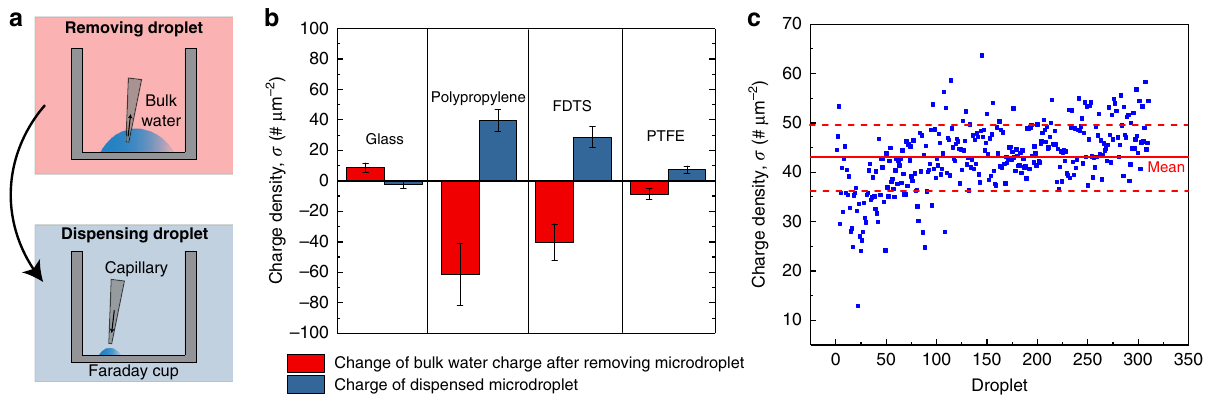
Fig. 4 Quanti fi cation of the excess electrical charges carried by water droplets during pipetting. a Removing droplet: we placed 1 mL of water (reservoir) inside a Faraday cup connected to an electrometer and extracted 15 – 50 μ L aliquots at a time. Dispensing droplet: next, we dispensed the exctracted droplets into an electrometer to quantify their excess charges. We found that the charges incurred by the water reservoir and the withdrawn aliquots were equal and opposite. b Charge balance: charging of the water reservoir and the withdrawn aliquot using capillaries made of borosilicate glass, polypropylene, FDTS-coated glass, and PTFE. The charges on the water reservoir after withdrawing water aliquots using different capillaries are presented in red; commensurate (opposite) charges on the aliquots are presented in blue. (Note: the y -axis presents charge density, obtained by normalizing the charges by the liquid-solid interfacial area). Error bars represent the standard deviation of ten measurements. c Charge density of over 300 water droplets (50 μ L each) loaded and dispensed from the same polypropylene capillary into an electrometer. The red dotted lines represent the ± 1 standard deviations about the mean value of the surface charge density of polypropylene: σ ¼ (cid:2) 0 : 7 ± 0 : 1 nC cm − 2 or 43 ± 7 # μ m − 2 .